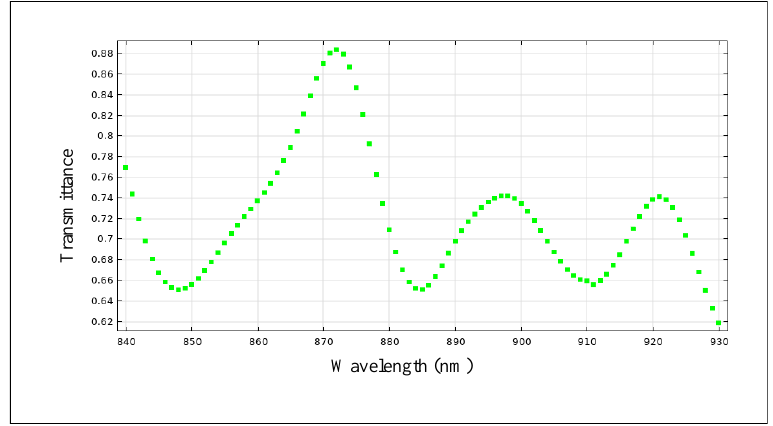
Figure 14. The transmittance diagram corresponding to Figure 13a,b.